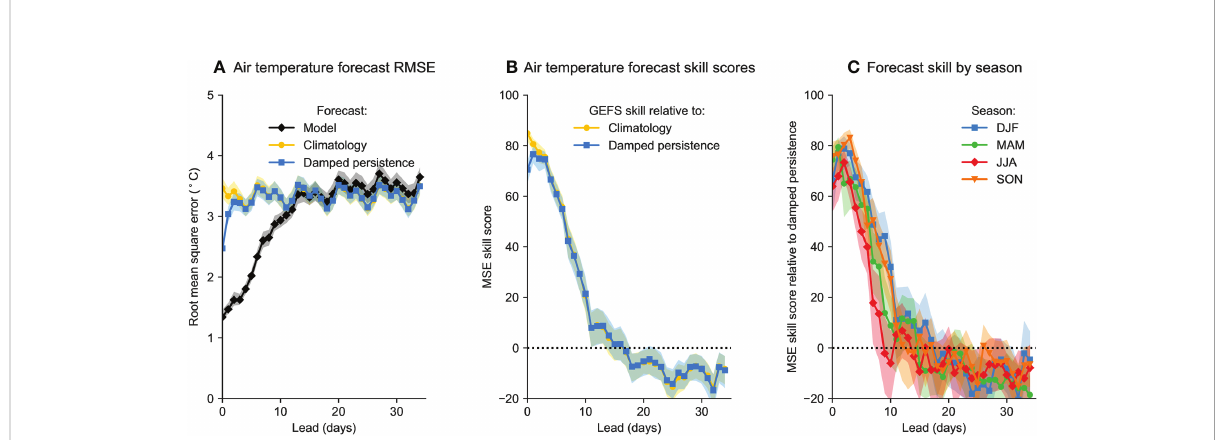
FIGURE 3 (A) Root mean square error of all GEFS ensemble mean air temperature forecasts compared with the error of the climatology and damped persistence reference forecasts. (B) Mean square error skill scores for all ensemble mean air temperature forecasts relative to the climatology and damped persistence reference forecasts. (C) MSE skill scores calculated separately for each season, using only damped persistence as the reference forecast. In all panels, shaded regions are 90% con fi dence intervals.